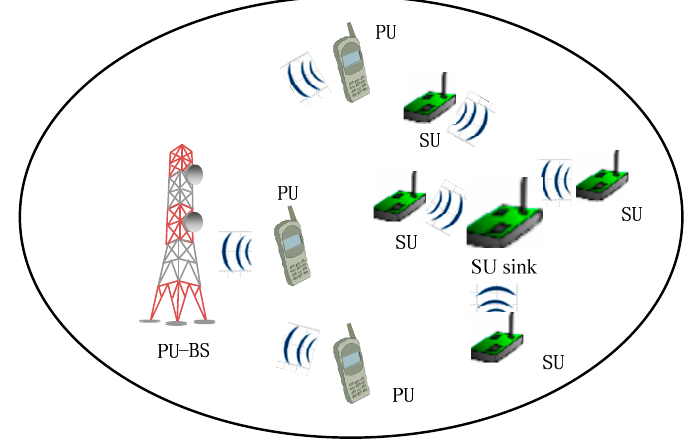
Figure 1. System model of cognitive radio sensor networks (CRSNs).